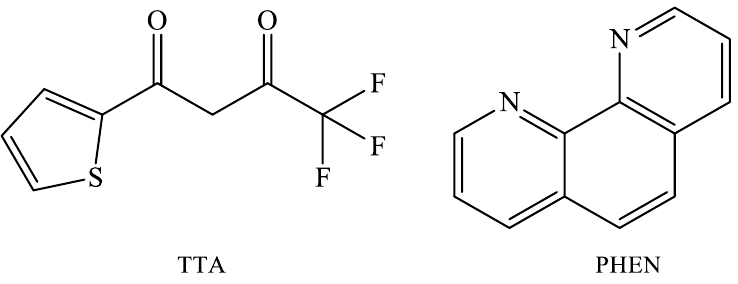
Figure 8. TTA and PHEN structures.